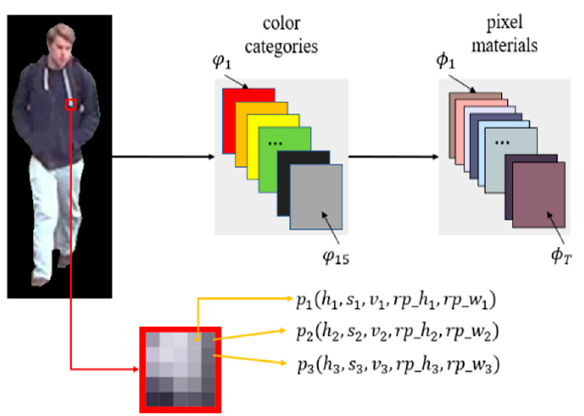
Figure 3. The pixel material extraction process description. h i , s i , v i , rp _ h i , rp w hue, saturation, value of the pixel, height distance from the origin, and width distance from the origin of the pixel, respectively. N is the total number of ROI pixels.